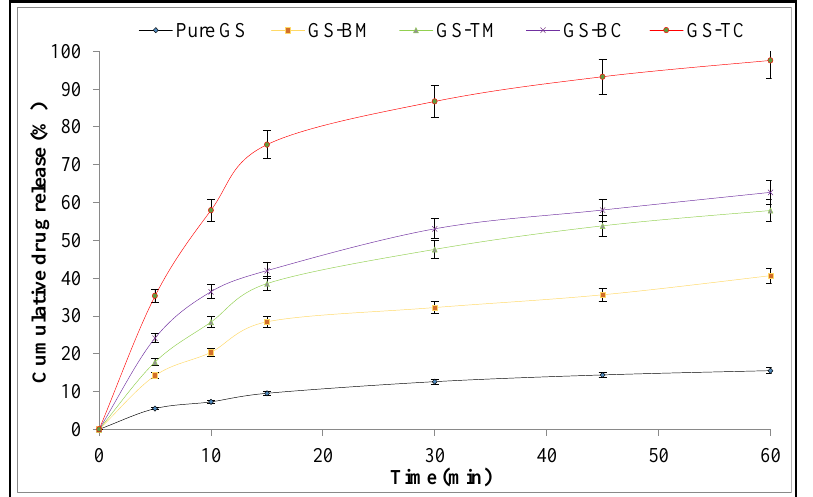
Figure 4. Dissolution study of Genistein (GS), binary physical mixture (GS-BM), ternary physical mixture (GS-TM), genistein binary complex (GS-BC) and genistein ternary complex (GS-TC). Difference was considered significant if p < 0.05.